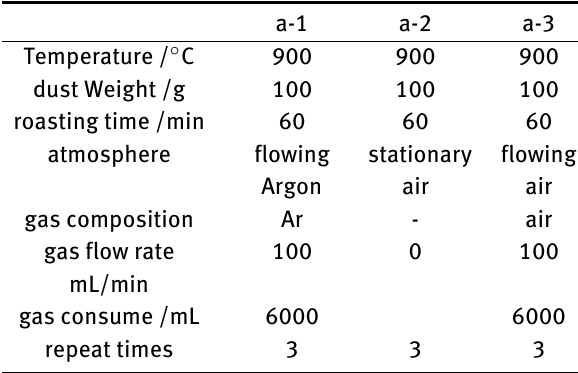
of dechlorination and [Zn] reclaiming were investigated af- ter the roasting treatment.